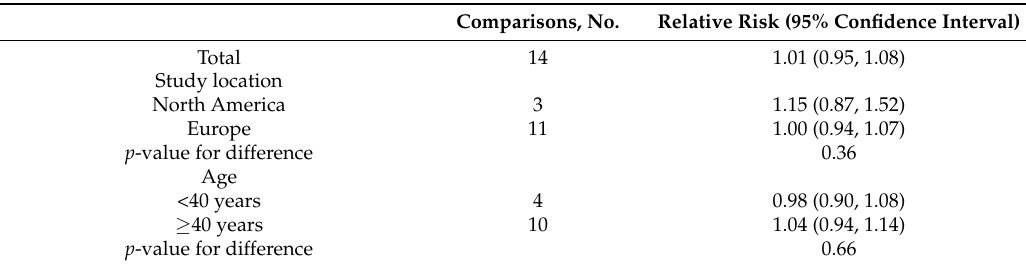
Table 2. Stratified analysis of the association between yogurt consumption and the incident risk of cardiovascular disease.